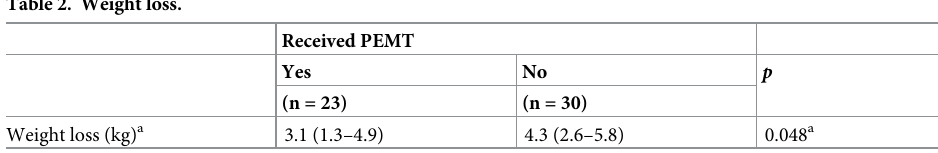
Table 2. Weight loss.